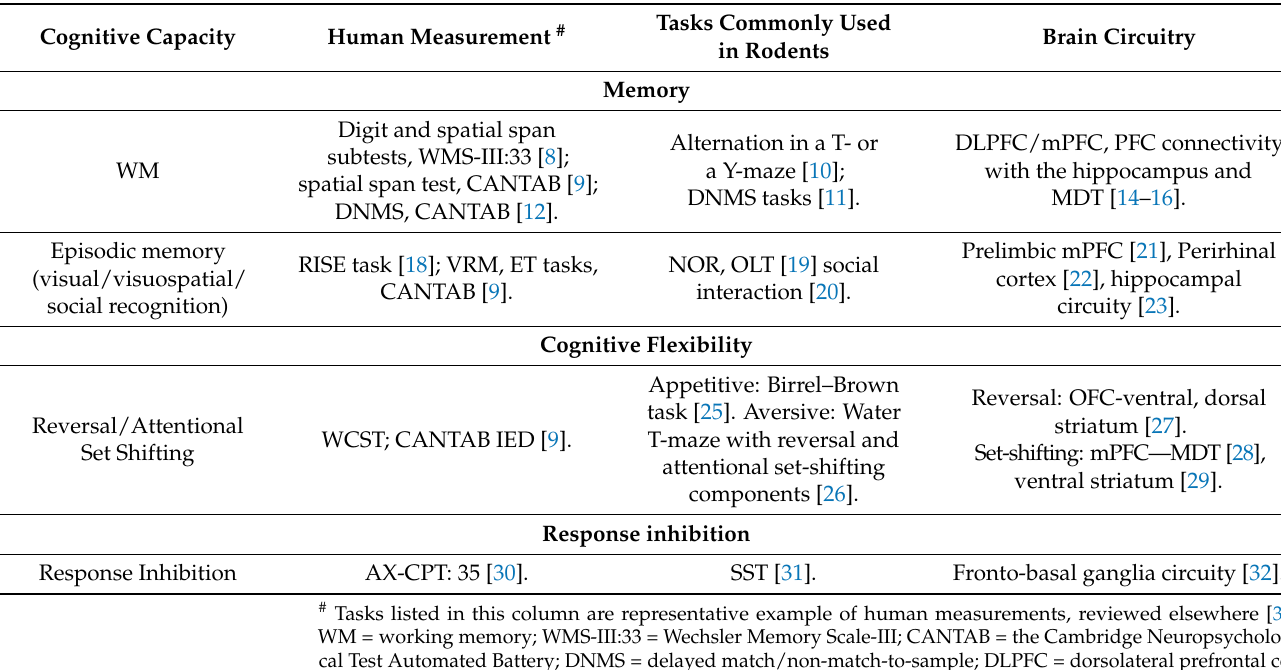
Table 1. Measuring cognition in humans and rodent